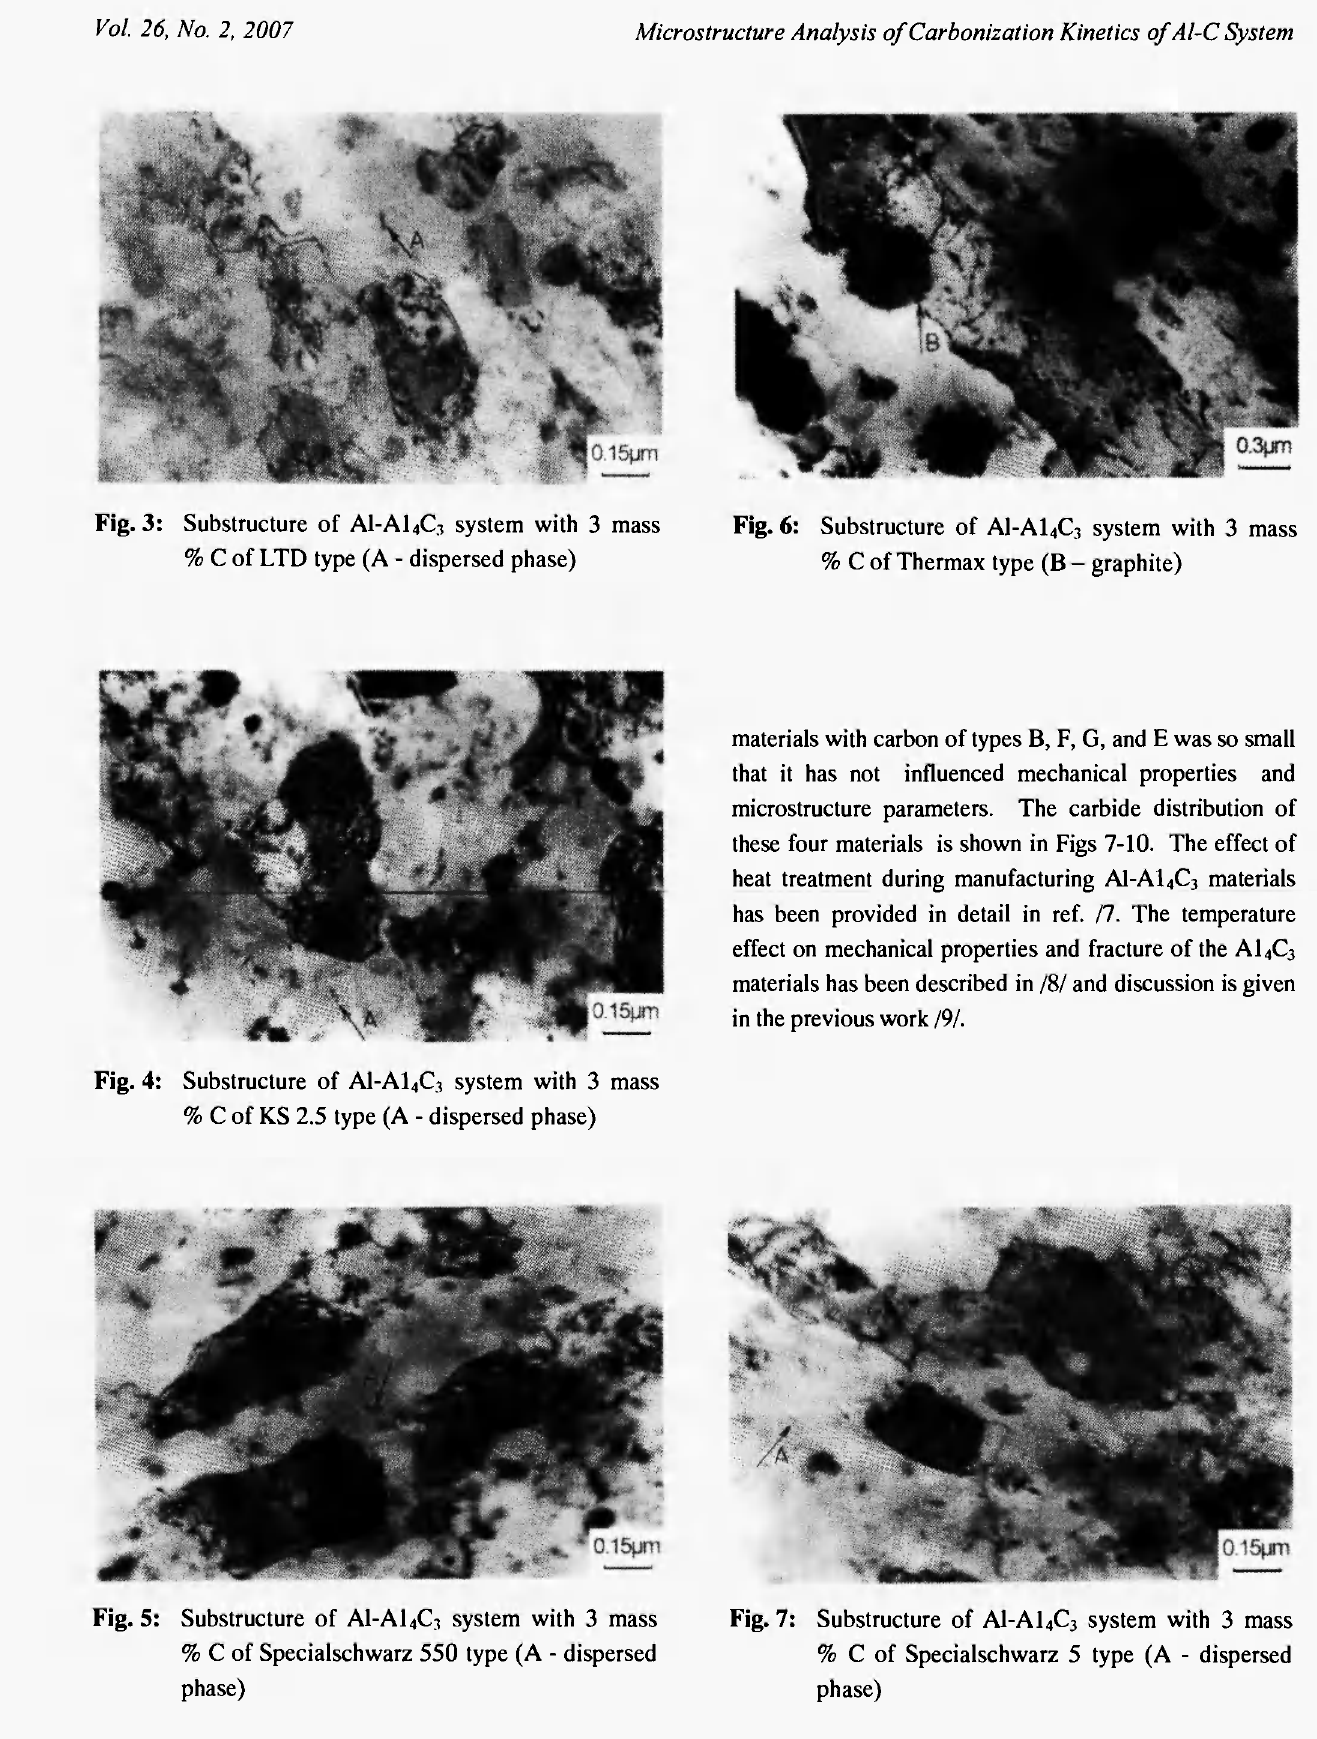
Fig. 7: Substructure of AI-AI4C3 system with 3 mass % C of Specialschwarz 5 type (A - dispersed phase)